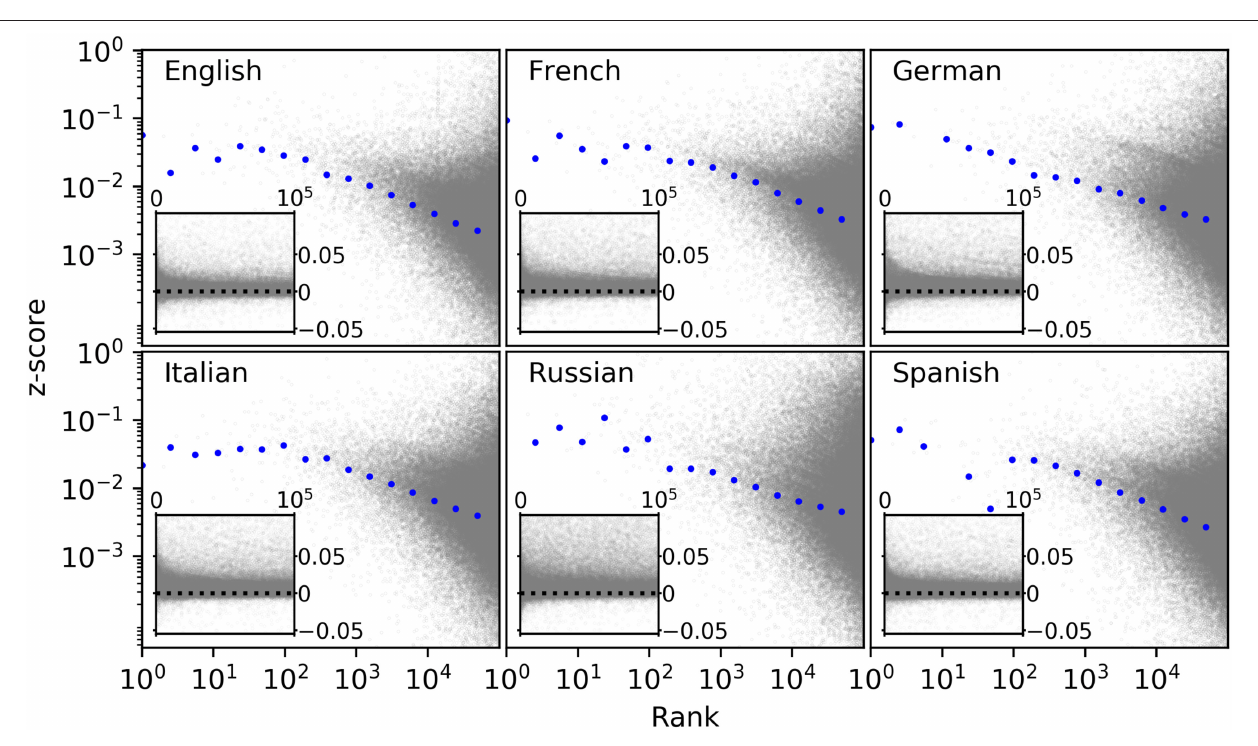
FIGURE 5 | z -scores between empirical and null model digrams. z -scores, calculated from Equation (13), for the top 10 5 2-grams in 2008. Each point represents a 2-gram found in the empirical data. The blue dots show the median z -score of logarithmically binned values (first bin contains only the first rank; each consecutive bin is twice as large as the previous one). The inset shows the same values on a linear scale y axis, with a dashed line indicating z 0. = used in a similar way to an individual word. We observe that the more likely to appear together than they are in other contexts majority of 2-grams have positive z -scores, which simply reflects (for example, “led zeppelin” in the Spanish datasets), suggesting the existence of non-random structure in language ( Figure 5 that the combination of words may form a linguistic token that is